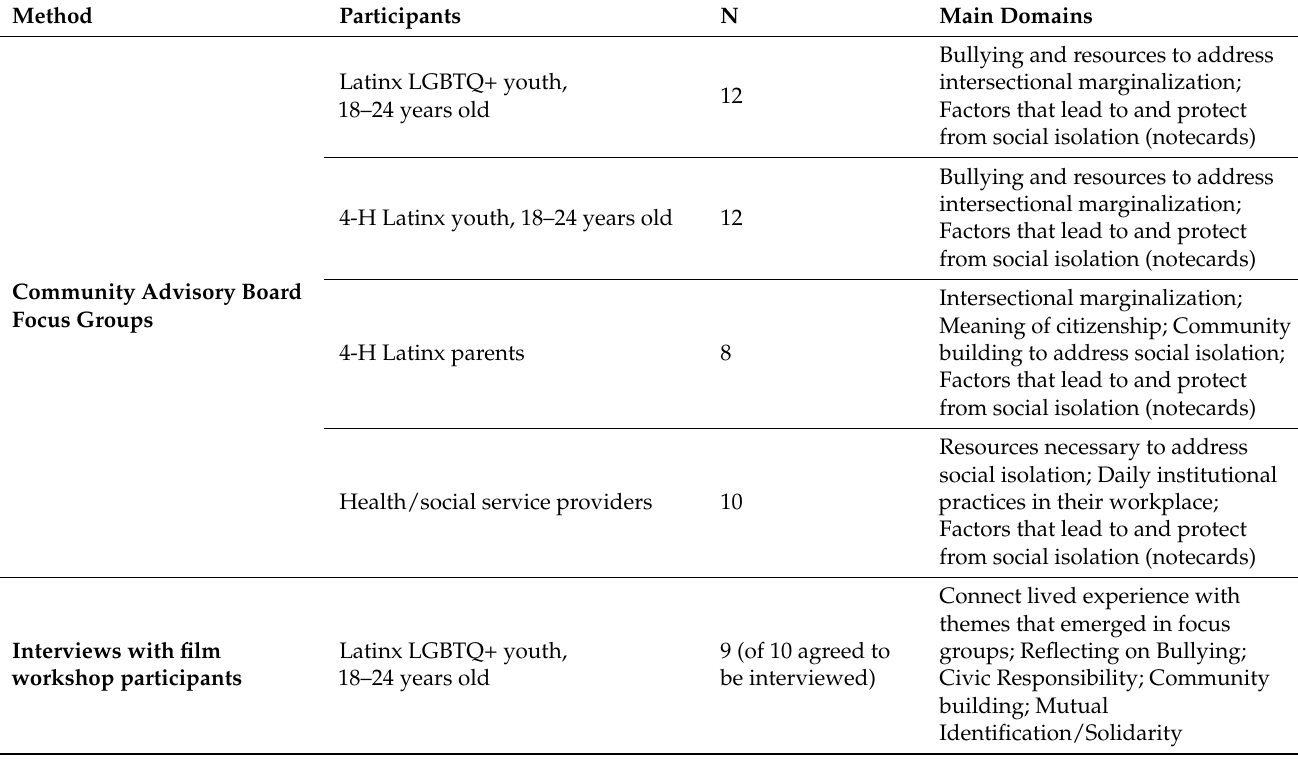
Table 1. Methods used, participant type, and